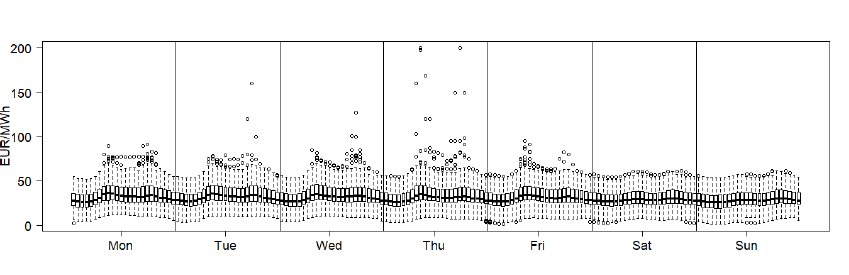
Figure 4. Boxplots of the electricity price for each hour of the week (29 December 2014–24 Novem- ber